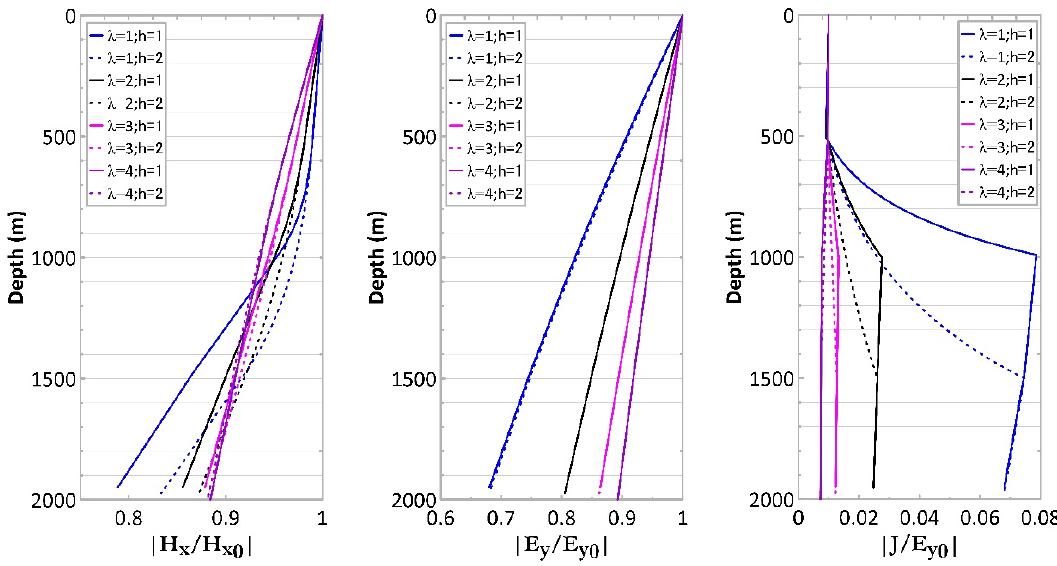
Figure 7. Similar to the case shown in Figure 5 except that the anisotropic dip angle is 60° in the model .